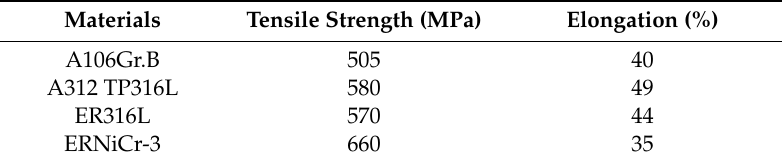
Table 6. Mechanical properties of base metals and filler consumables.